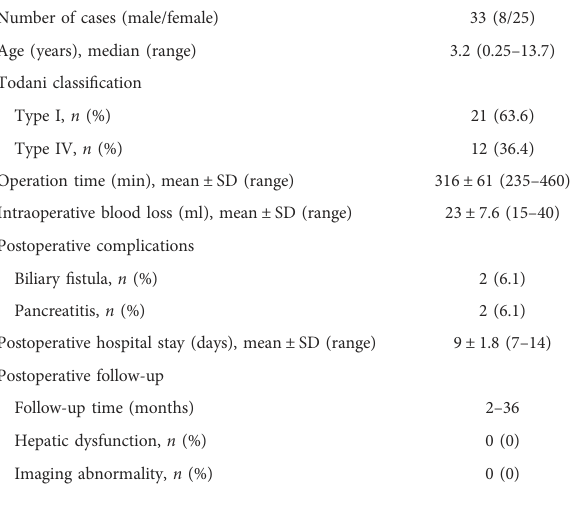
TABLE 1 Relevant data for the cohort ( N =33).